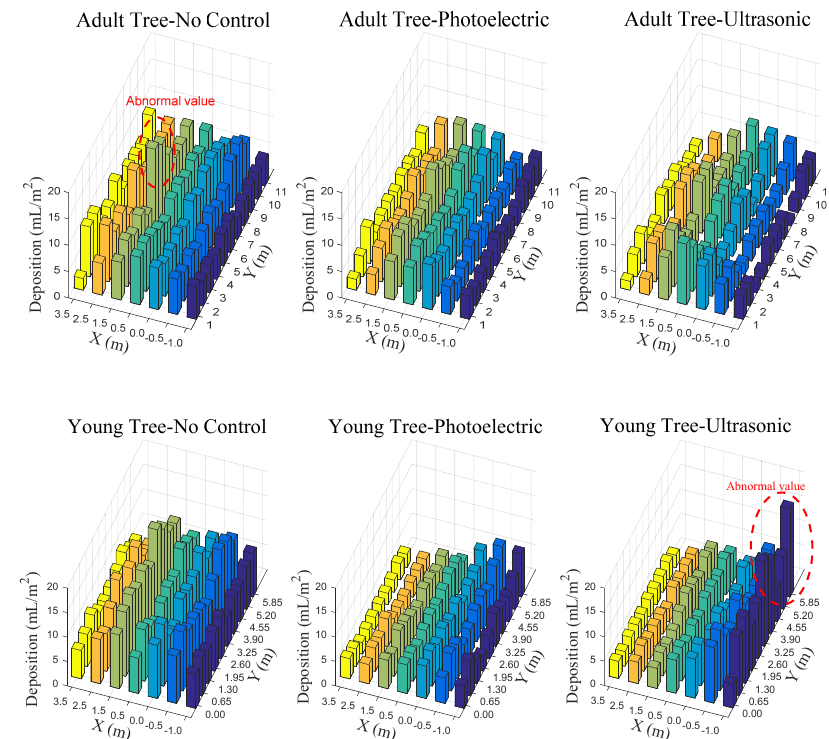
Figure 10. Ground deposition distributions for adult trees and young trees: X : location of sampling point in spray direction, Y : location of sampling point in running direction of sprayer. Table 3. Spray volume savings under different spraying systems.